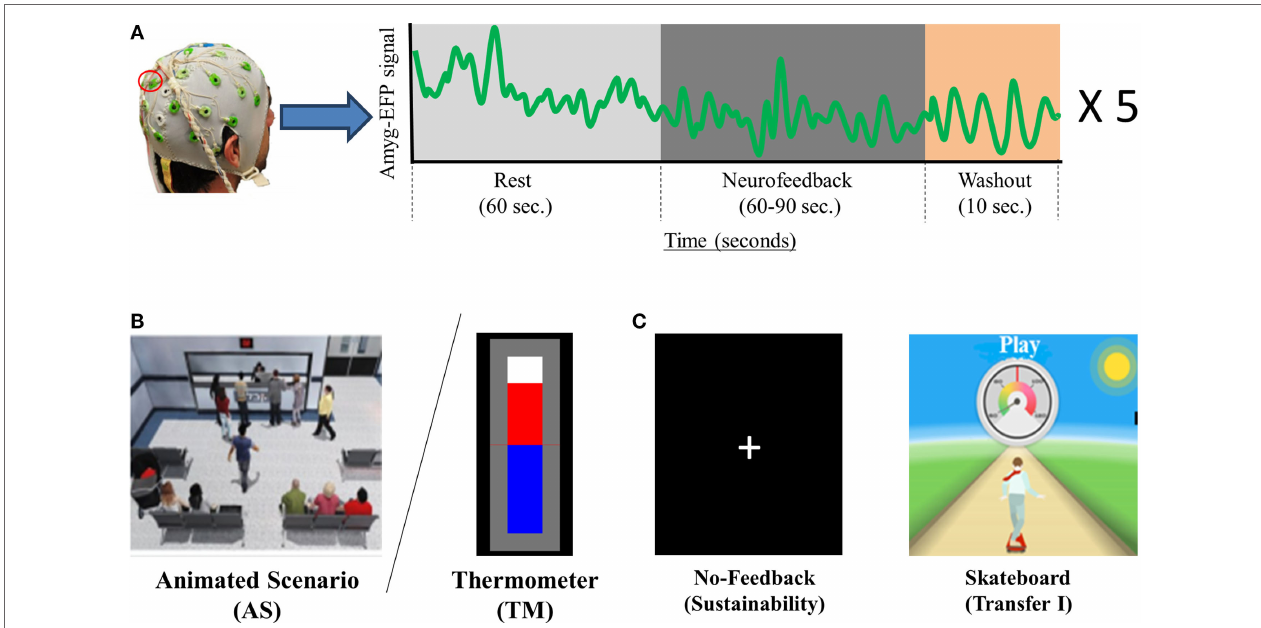
FigUre 1 | nF training procedure and conditions . (a) Participant’s EEG is continuously recorded via one Pz electrode (marked in red) and momentary amyg-EFP activity is calculated online through rest. NF and washout periods (a time course for one training cycle is shown in the box on the right) (B) The training interfaces: either AS (AS. left) or thermometer (TM. Right). (c) Interfaces presented on the second session. The no-feedback consisted of a dark screen with a fixation cross (left) and the first transfer trial consisted of a 2D moving skateboard